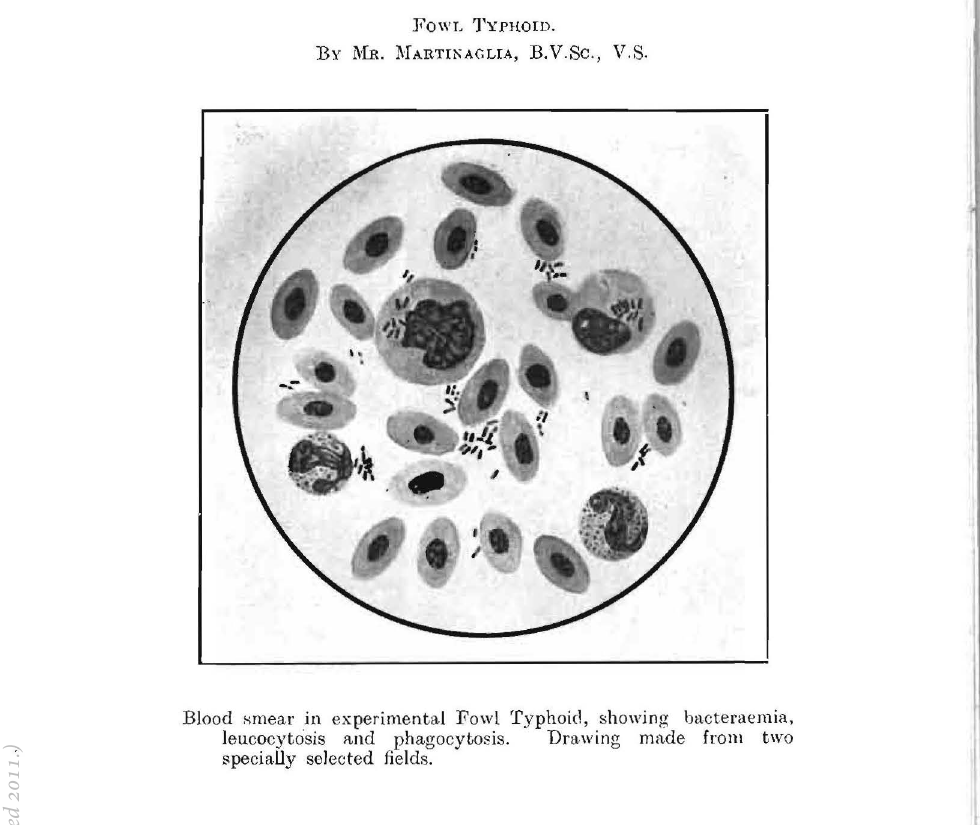
specia.lly selected fields.